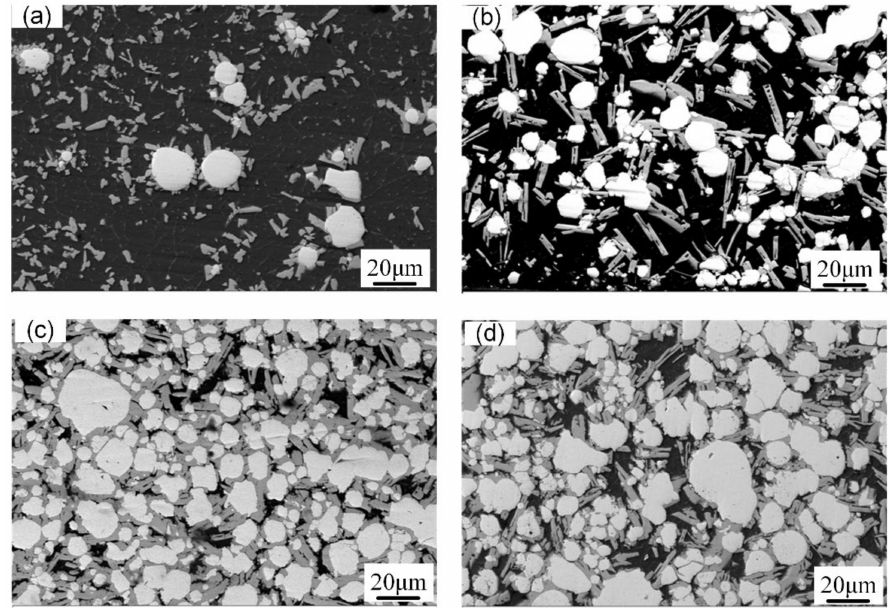
Figure 6. Microstructure of W/Al composite layers with powder feeding rates of ( a ) 7 g/min,